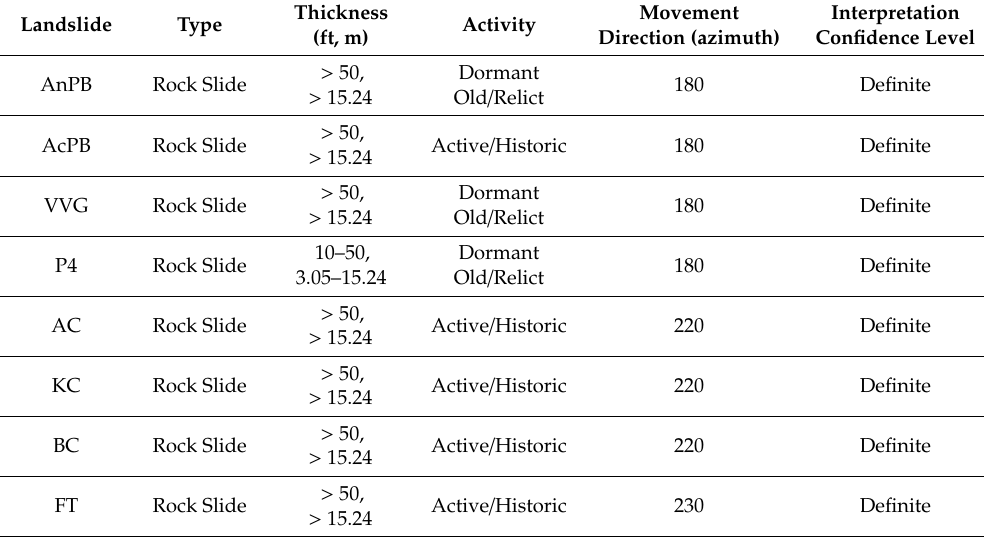
Table 2. Landslide